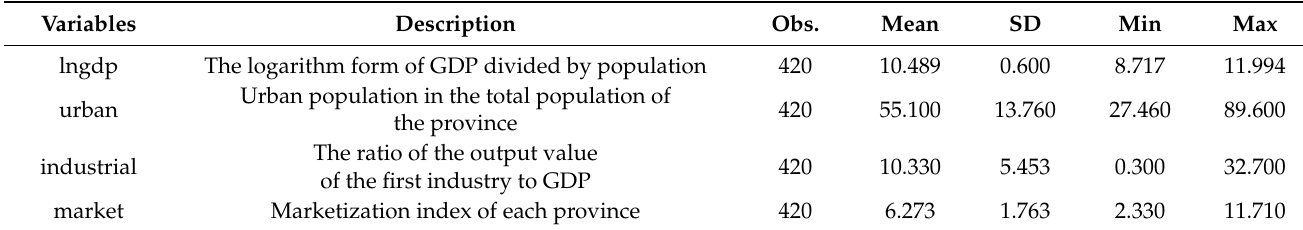
Table 2. Descriptive statistics of variables.